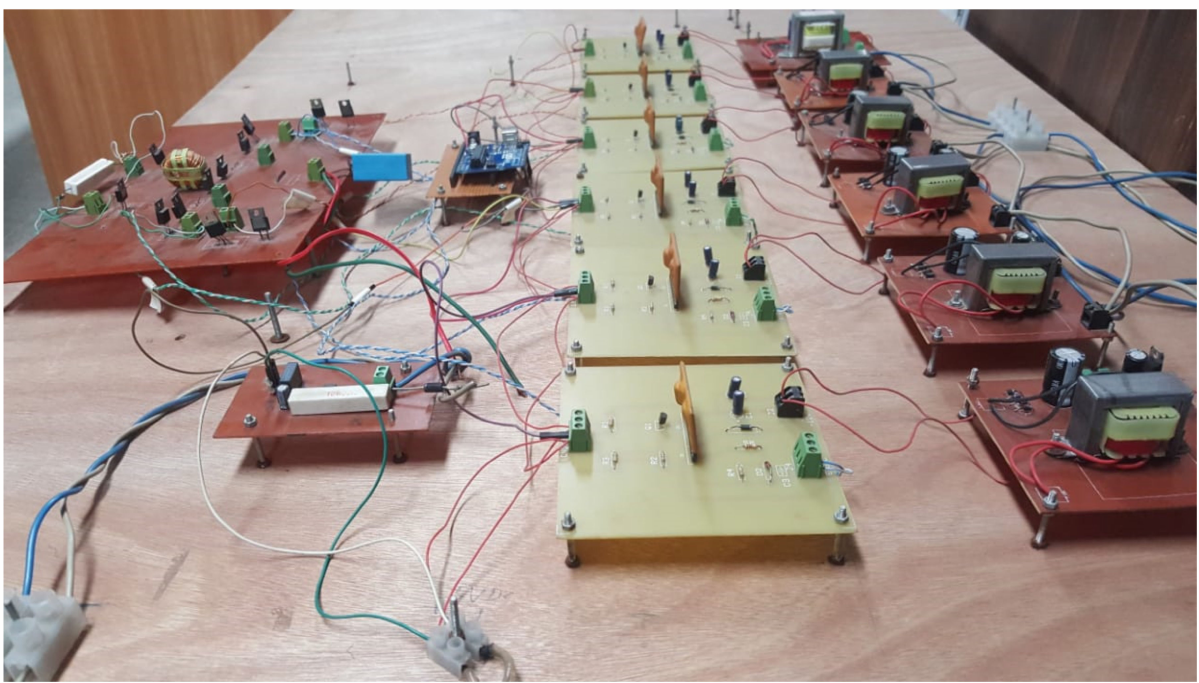
Figure 10. Practical test